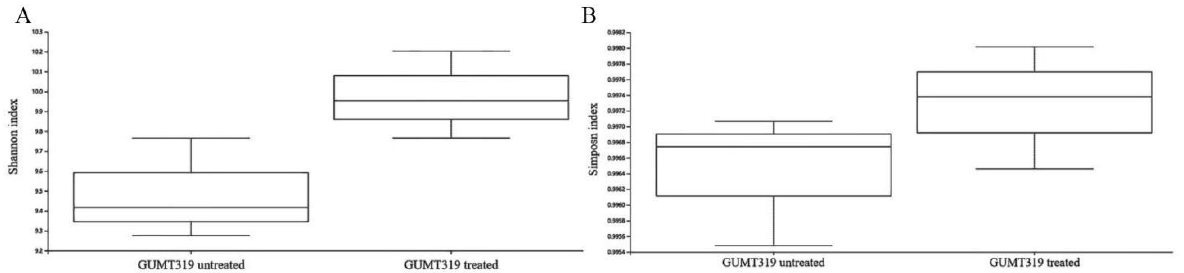
Figure 5. Species diversity analysis of the microbes in GUMT319-treated and untreated grape plant rhizosphere. Both ( A ) Shannon index and ( B ) Simpson index results showed that the species richness of rhizosphere microorganisms in the GUMT319 treatment groups was higher than that in the untreated group.